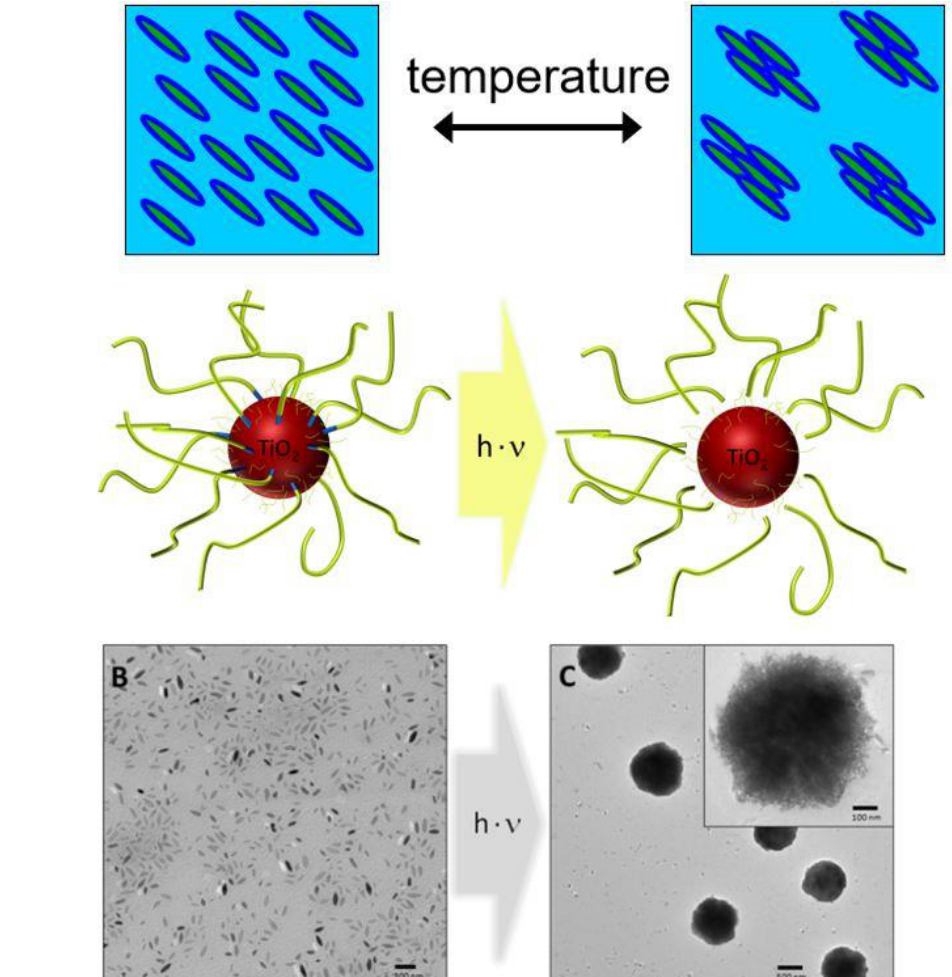
Figure 5. Ways to destabilize polymer coated nanoparticles with an external stimulus and to induce a coagulation. ( a ) Nanoparticles coated with a polymer with an lower critical solution temperature coagulate during temperature increase [39]; ( b ) Nanoparticles coated with polymers with a photosensitive group with in the polymer backbone allow it to split-off the stabilizing polymer corona [81]; lower part reproduced with permission of [81], published by Wiley-VCH, 2014. Semiconducting polymers (mostly conjugated polymers) and fluorescent inorganic nanoparticles have been investigated separately for some time. The combination of both materials is, however, highly interesting as it can lead to nanocomposites whose properties are much superior to